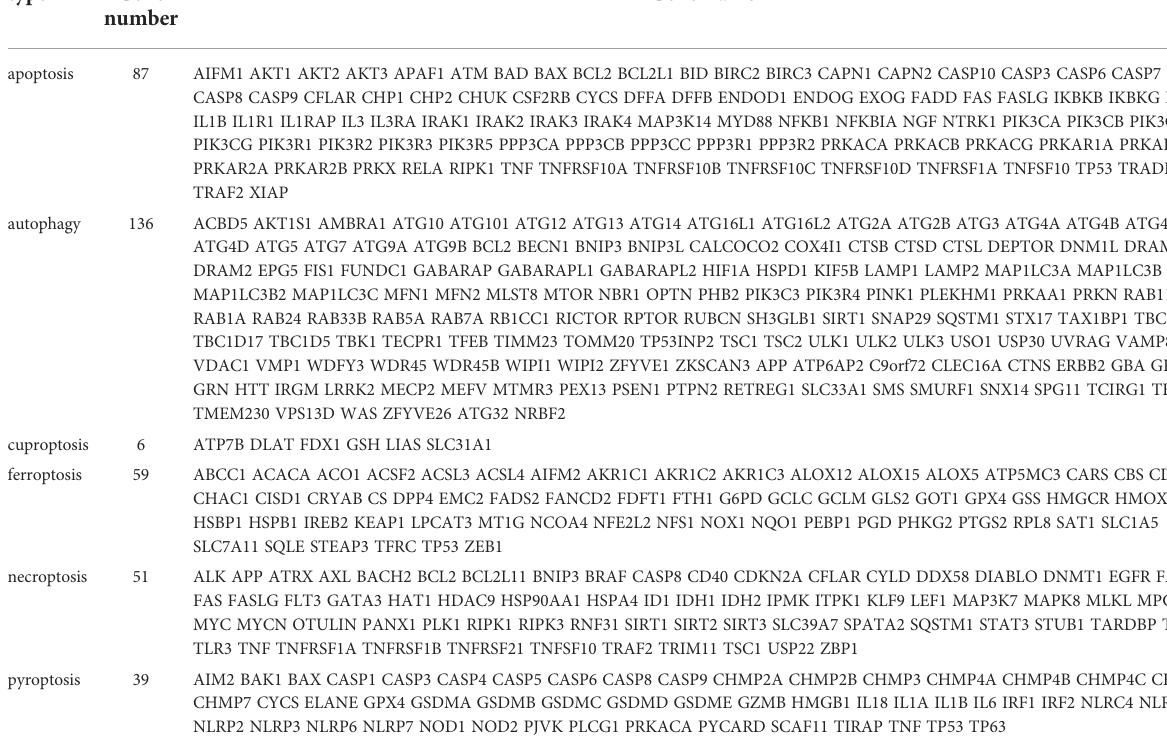
TABLE 1 List of pan-PCD